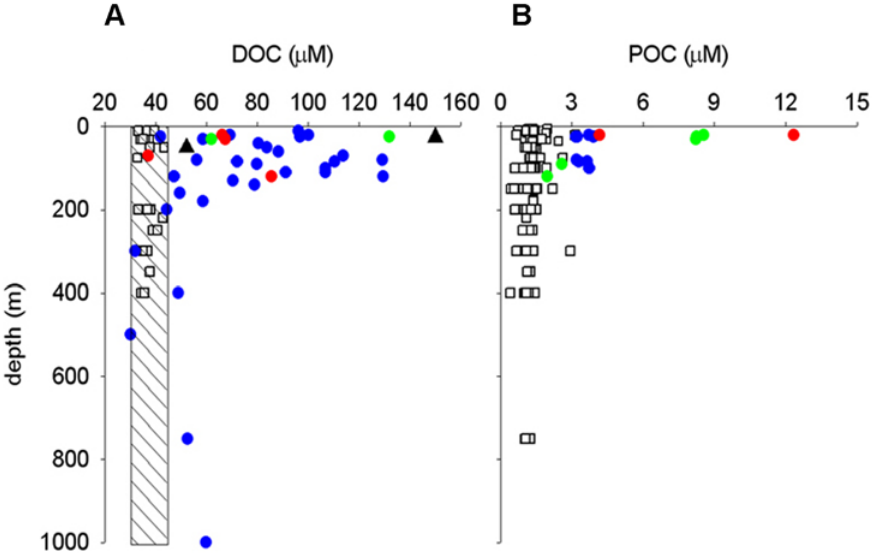
Figure 3. Depth distribution of organic matter pools during summer and winter cruises. Summer 2004: blue circles=ACC water; red circles=shelf water; green circles=mixed water; empty square=Winter 2006. (Panel A) DOC=Dissolved organic carbon. The data presented are measurements of total organic carbon, but since POC represents a negligible contribution to total organic carbon (POC represented only between 7% and 2% of the total pool) we can consider the analysis as DOC values. The shaded area covers the range of winter concentration. For a comparison, a range of variations of DOC from the FRUELA cruise study area in summer (Gerlache Strait, Bransfield Strait and Bellinghausen Strait) [22] has been reported (black triangles). (Panel B) POC=Particulate organic